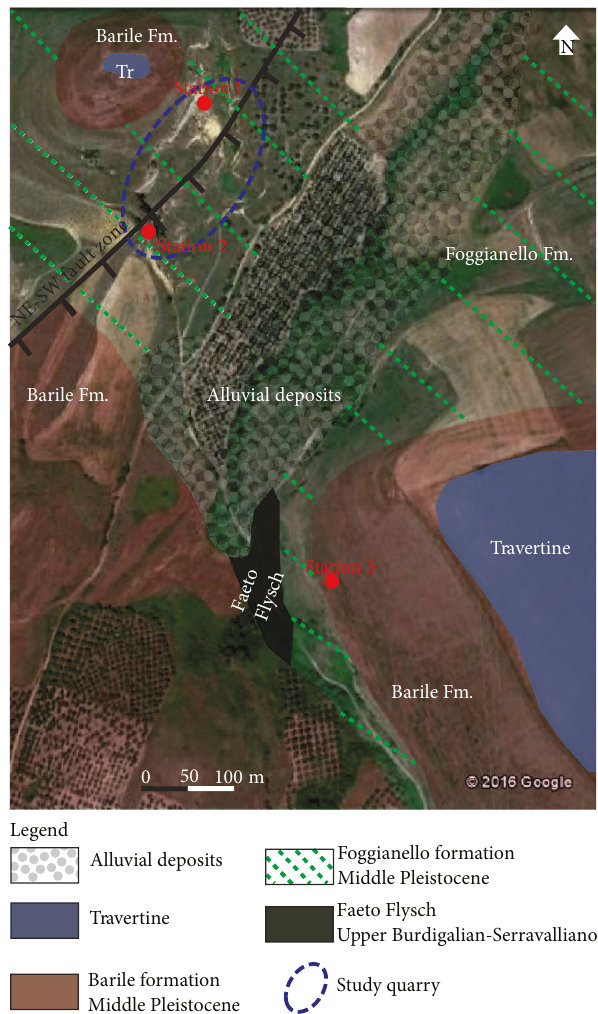
Figure 4: Geological map based on Google earth image of the Rapolla area, in which the location of the sampling sites and the investigated outcrops for structural analysis are